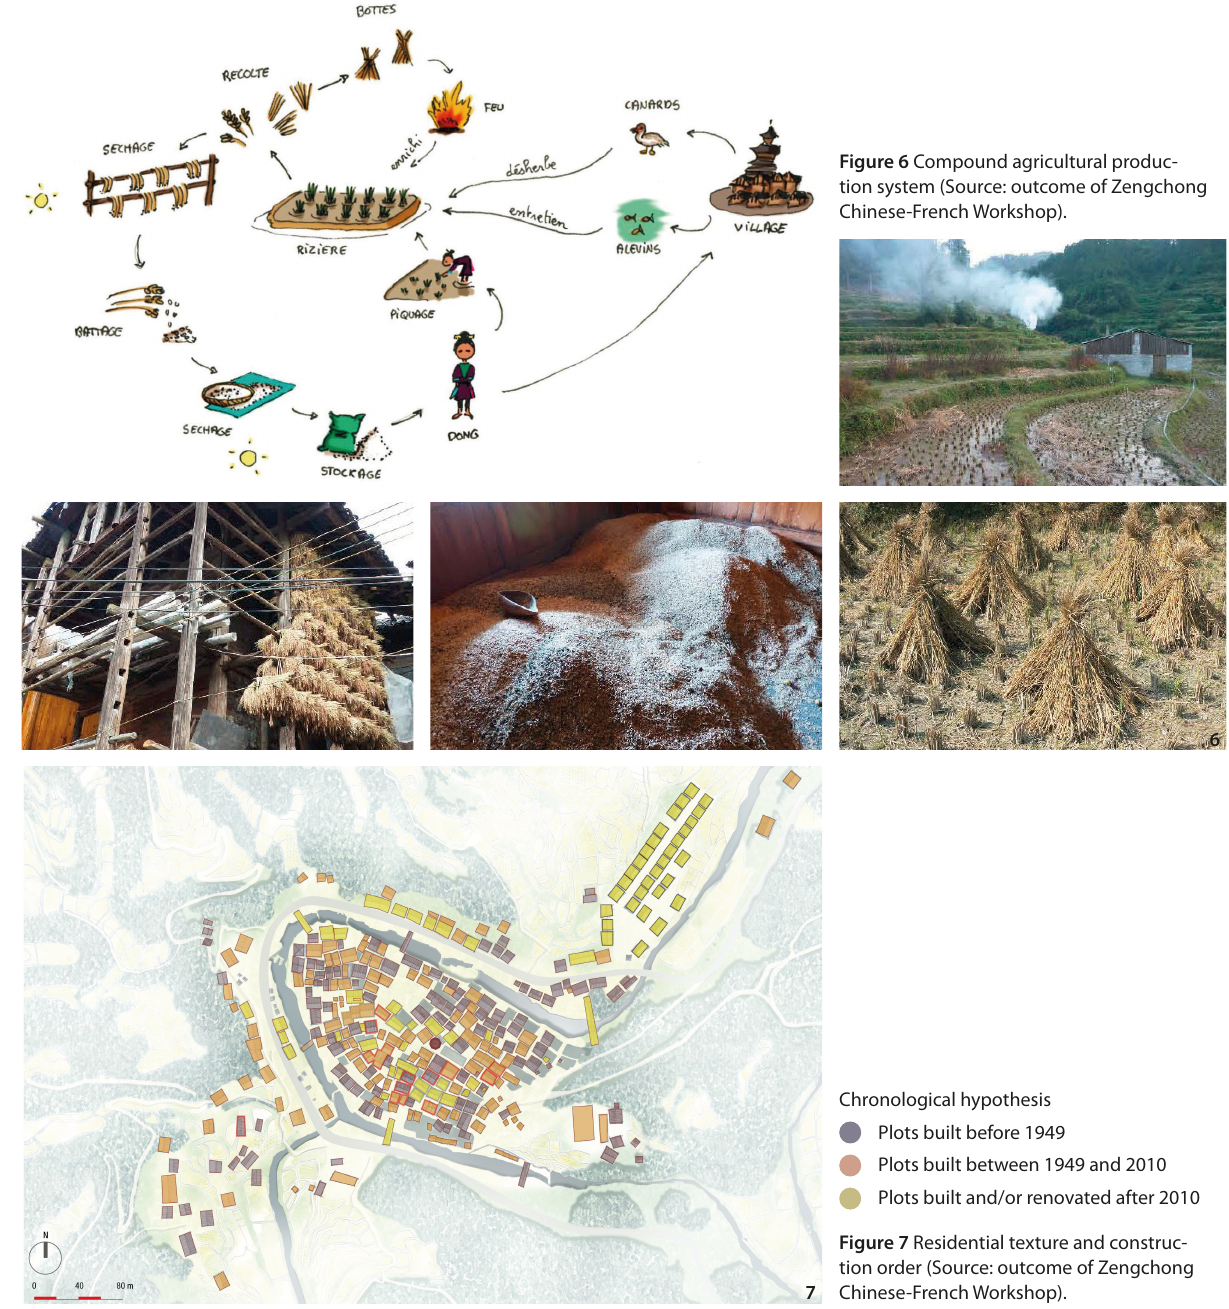
Figure 6 Compound agricultural produc- tion system (Source: outcome of Zengchong Chinese-French Workshop).